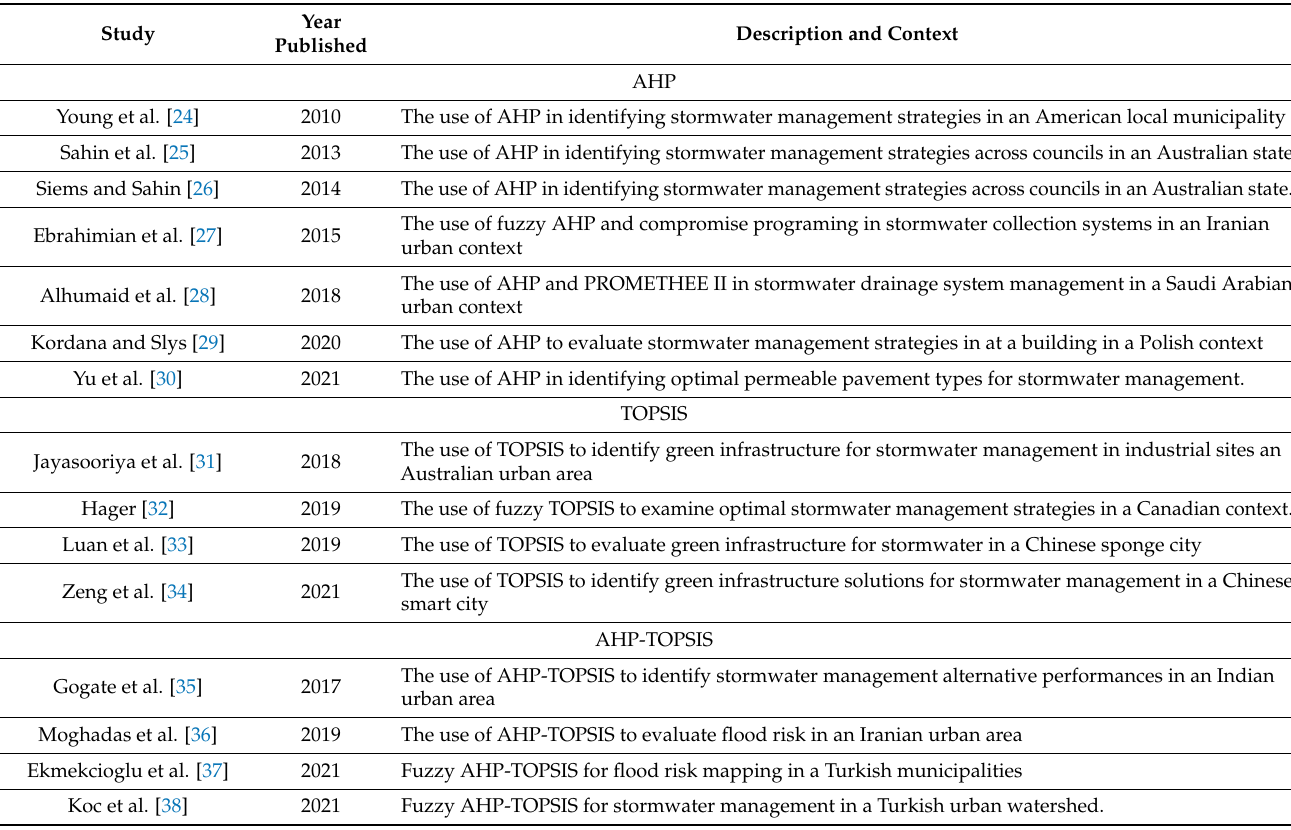
Table 1. Recent literature on the AHP and TOPSIS methodologies within stormwater